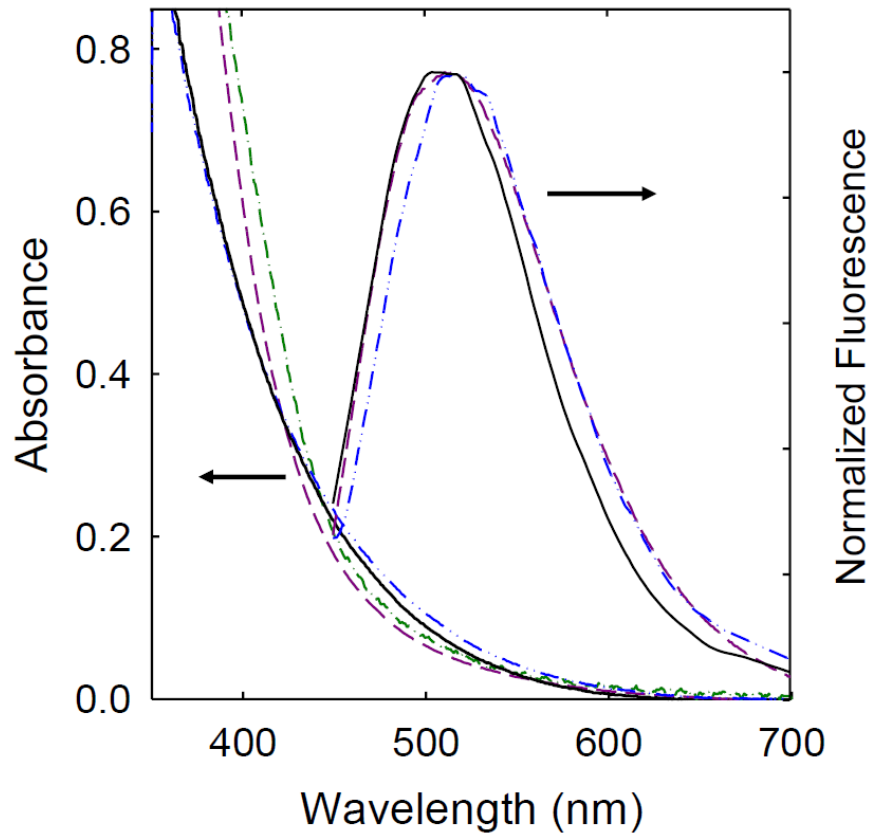
Figure 3. Absorption and fluorescence spectra of PEI&PEG-C/TiO 2 -Dots (solid, black) and PEG- C/TiO 2 -Dots (dash-dot-dot, blue), with those of PEI-CDots (dash, purple) and aqueous suspended small carbon nanoparticles (dash-dot, green, absorption only) for comparison. Both PEG-C/TiO 2 -Dots and PEI&PEG-C/TiO 2 -Dots with exposure to visible light were found to kill bacterial cells, as reported previously [18]. With each hybrid dot